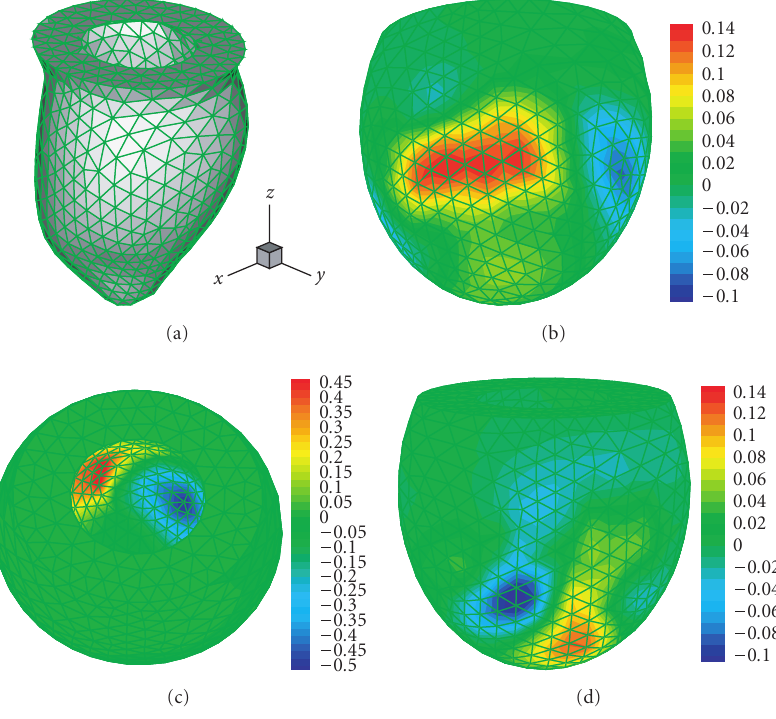
Figure 6: Same as Figure 5, but at t = 0 . 6 second (active